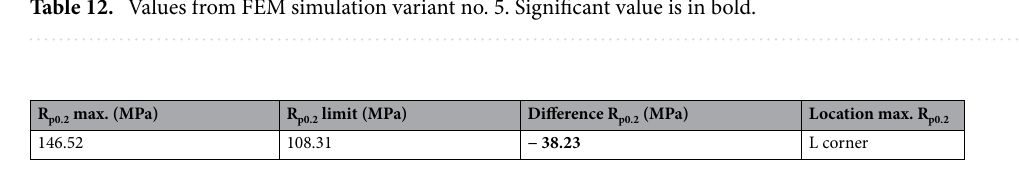
Table 13. Values from FEM simulation variant no. 6. Significant value is in bold.